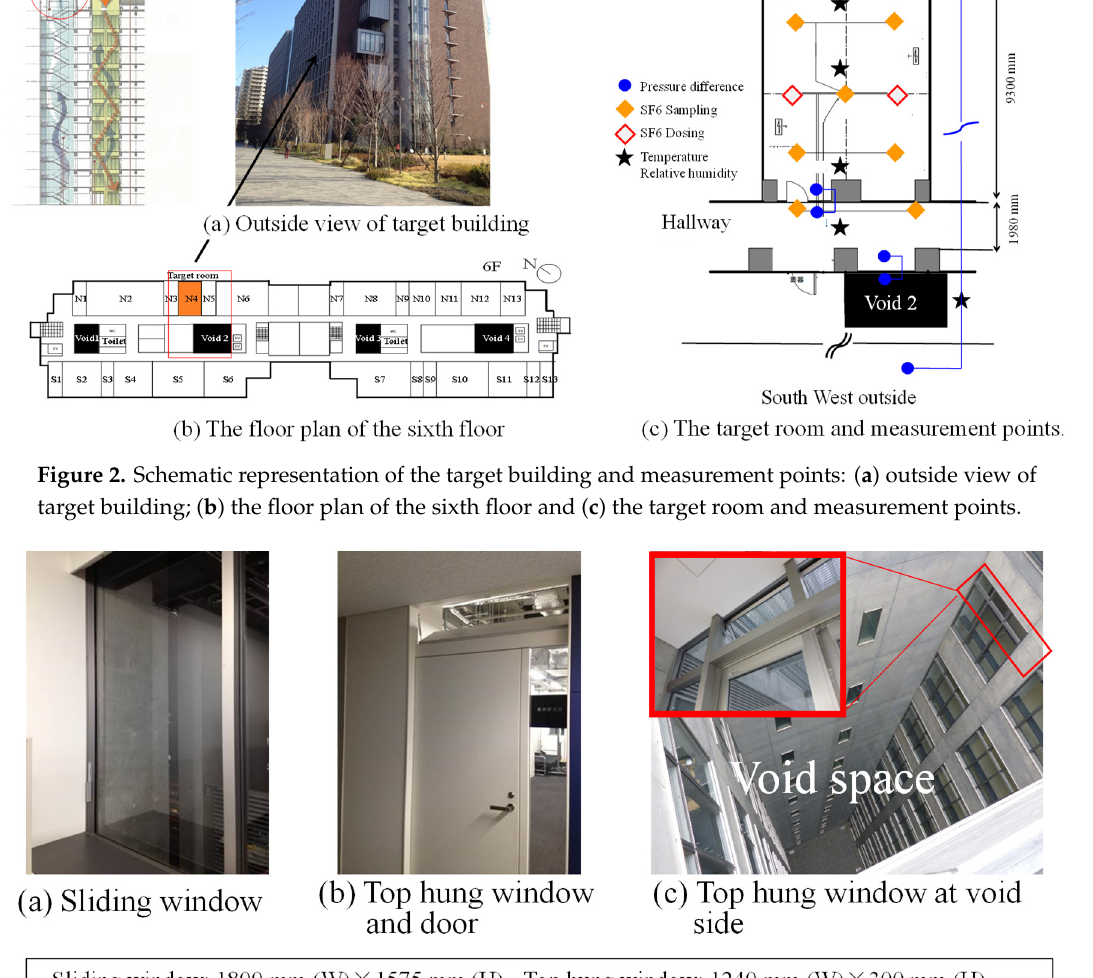
Figure 3. Schematic representation of the target building windows and door: ( a ) sliding window; ( b ) top hung window and door and ( c ) top hung window at void side.